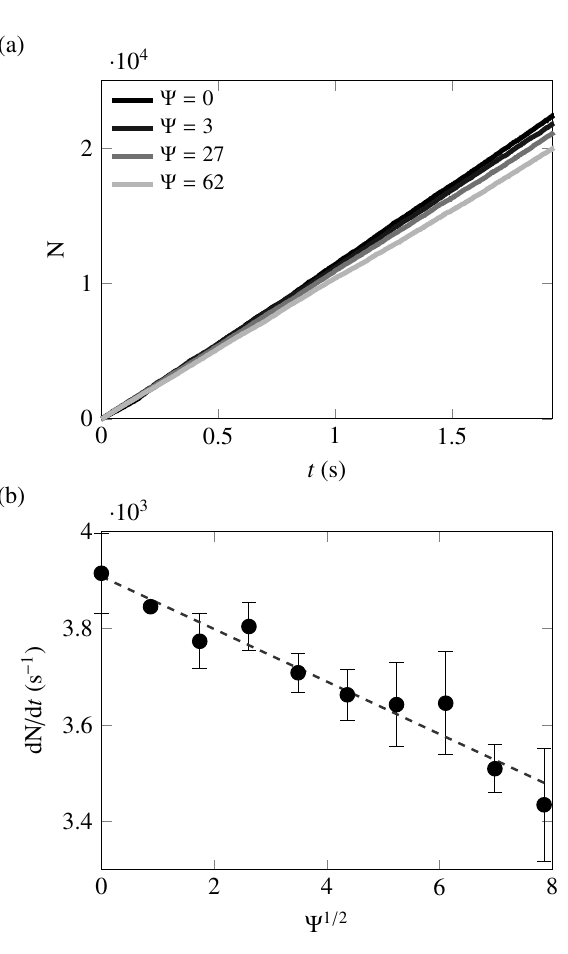
Figure 2. (a) Cumulative number of beads in the lower part of the cell during time for di ff erent magnetic field. (b) Flow rate of the beads in the silo given by the slope of the cumulative number of beads. The flow rate decreases when increasing the magnetic field intensity. The dashed line corresponds to a linear fit of the experimental data. Error bars correspond to the standard devia- tion over three